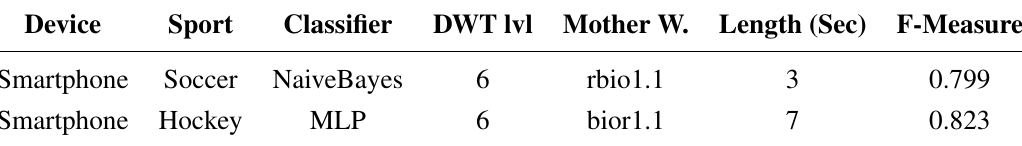
Table 8. Highest classification accuracies